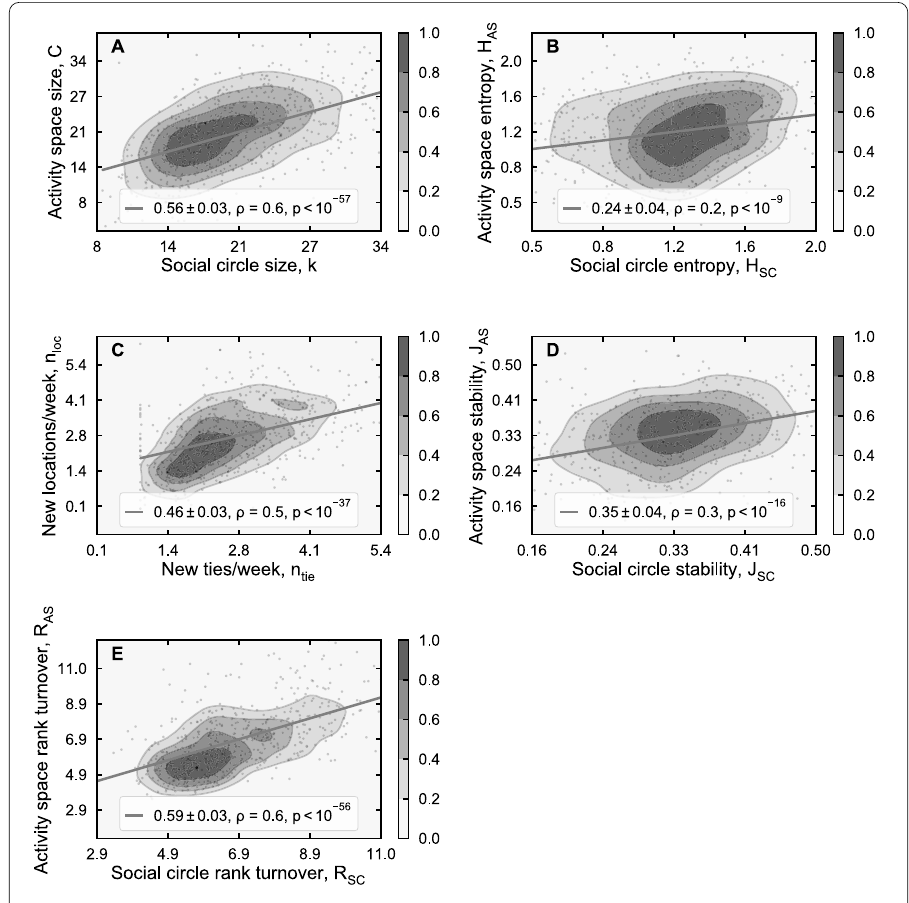
Figure 3 CNS dataset: correlation between the four dimensions of social and spatial behaviour. ( A ) Activity space vs social circle size. ( B ) Activity space vs social circle composition measured as their entropy. ( C ) Average number of new locations vs new ties per week. ( D ) Stability of the activity space vs the stability of the social circle measured as the Jaccard similarity between their composition in consecutive time-windows. ( E ) Rank turnover of the activity space vs the rank turnover of the social circle. Coloured filled areas correspond to cumulative probabilities estimated via Gaussian Kernel Density estimations. Grey lines correspond to linear fit with angular coefficient b reported in the legend. The Pearson correlation coefficient, with corresponding p-value, is reported in the